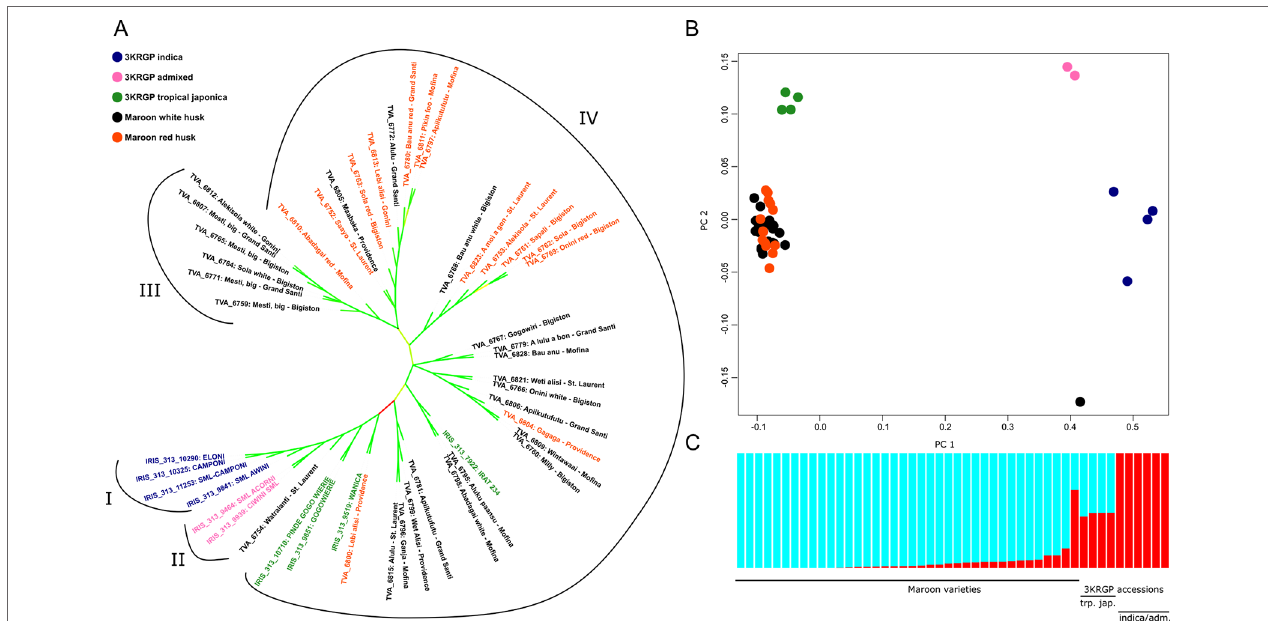
FIGURE 5 | Position of Maroon landraces within the Asian rice gene pool. (A) Approximately Maximum Likelihood (ML) tree of 39,595 homozygous SNPs. Branch lengths are not shown. Branches with low support values (< 0.70) are collapsed. Support values of the remaining branches are indicated on a scale from 0.70 (red) through 0.85 (yellow) to 1.00 (green). (B) Principal component analysis of 64,313 unlinked SNPs. (C) ADMIXTURE analysis of 64,313 unlinked SNPs at K = 2 ancestral populations